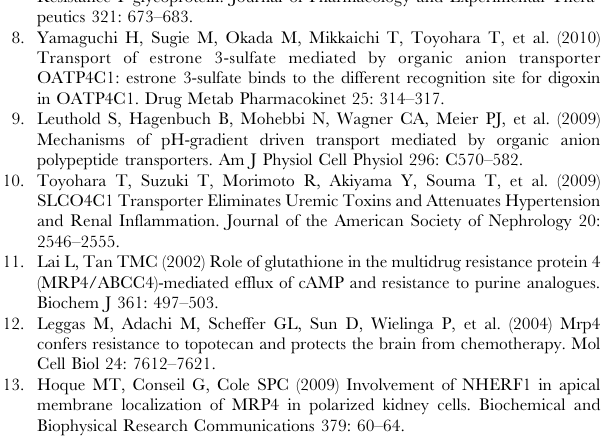
Figure S1 Immunolocalization of Oatp4c1 in polarized LLC-PK1 cells. Cells were double stained with Oatp4c1 (red) and ZO-1 (green). Nuclei were stained with DAPI (blue). Center image in the Oatp4c1 panel is a single optical section of the x–y plane while top and right images represent x–z and y–z planes, respectively, reconstructed from image stacks. The apical and basal sides can be demarcated by ZO-1 and the nuclei, respectively, in both x–z and y–z sections. (TIFF) Figure S2 Effect of sodium butyrate (NaB) on Oatp4c1 expression and subcellular localization in MDCKII cells. MDCKII-pcDNA and MDCKII-Oatp4c1 cells were treated with 1 or 5 mM NaB for 24 hr. Oatp4c1 expression (red) was assessed in cells grown in monolayers (A) and cell pellets were collected, lysed and subjected to PCR for Slco4c1 mRNA expression (B) or western blot for Oatp4c1 protein expression (C). 18 s and b -actin were used as loading controls in panels B and C, respectively. Oatp4c1 subcellular localization was assessed in polarized MDCKII cells by confocal microscopy (D). After treatment with 5 mM NaB for 24 hr, cells were double stained with Oatp4c1 (red) and ZO-1 (green). Nuclei were stained with DAPI (blue). Center image in the Oatp4c1 panel is a single optical section of the x–y plane while top and right images represent x–z and y–z planes, respectively, reconstructed from image stacks. The apical and basal sides can be demarcated by ZO-1 and the nuclei, respectively, in both x–z and y–z sections. (TIFF) Figure S3 Apical Oatp4c1 localization in rat kidney tubules was verified by four different antibodies. Paraformaldehyde-fixed paraffin-embedded rat kidney tissue sections were stained with different rabbit polyclonal anti-Oatp4c1 antibodies, as indicated. Color development with NovaRed signifies Oatp4c1 staining. All sections were counterstained with hematoxylin. Rabbit IgG was used as a negative control. Antibody specificity (PA1343) was also demonstrated by pre-absorbing the antibody with antigen peptide (STITVEEDLNKIENEG) over- night at 4 u C prior to use. PA1556 was generated against the peptide (SPDFEARAGKC) previously reported by Mikkaichi and colleagues [5].